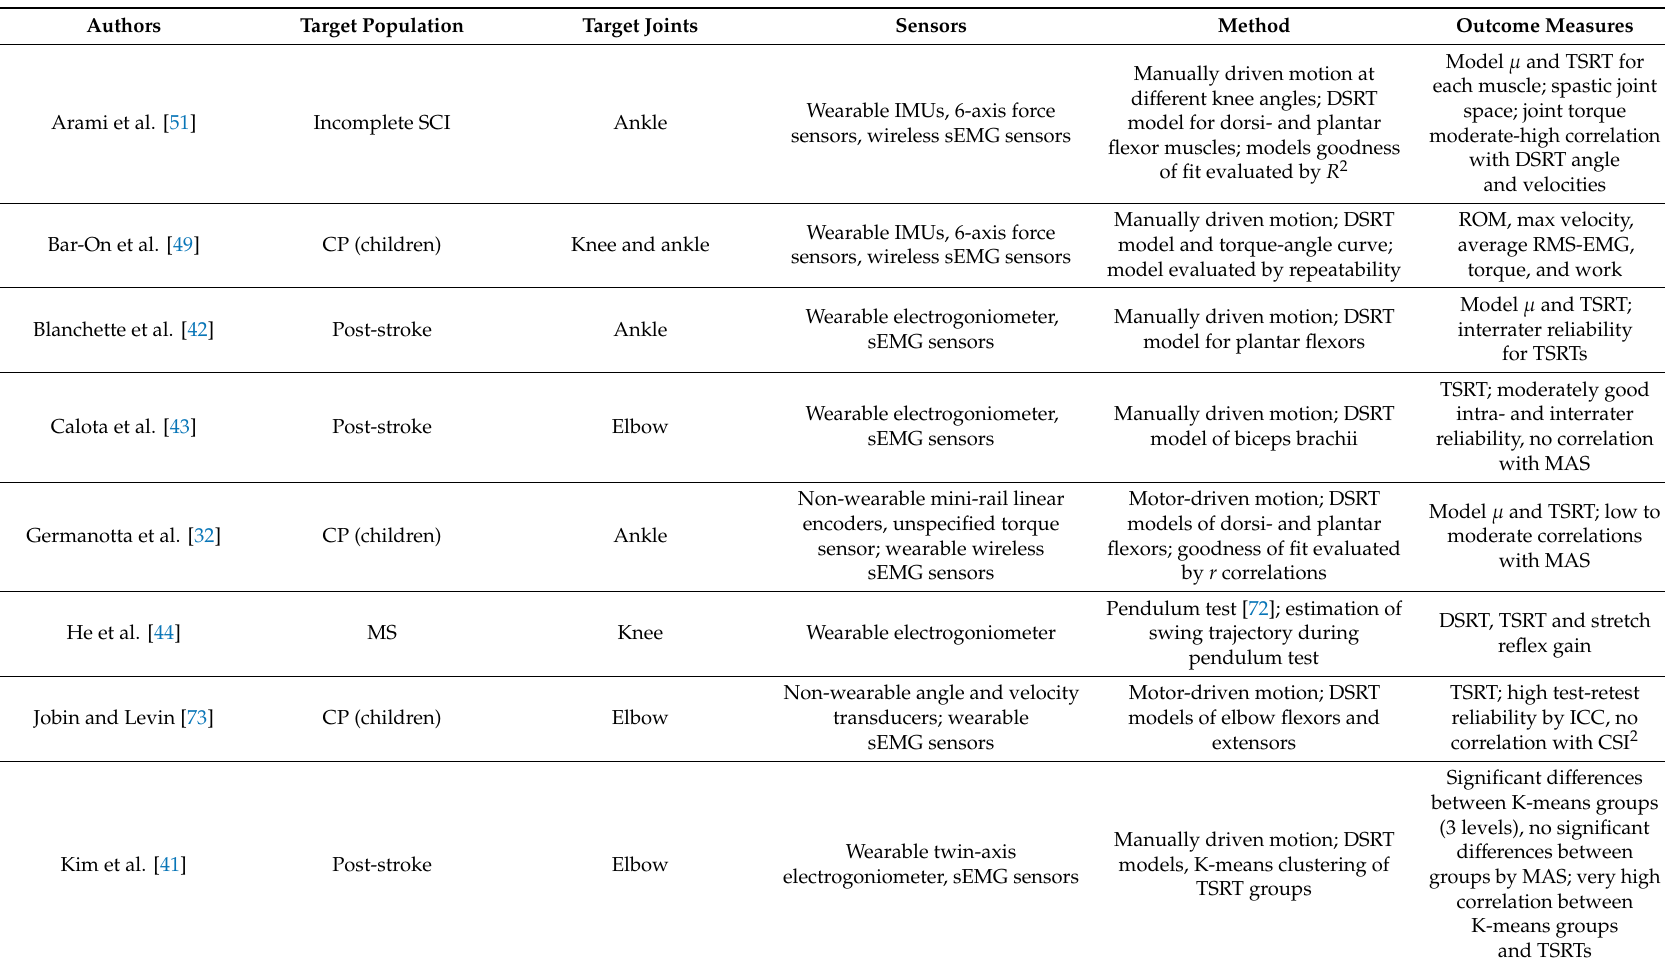
Table 4. Reviewed threshold-control approaches to modeling